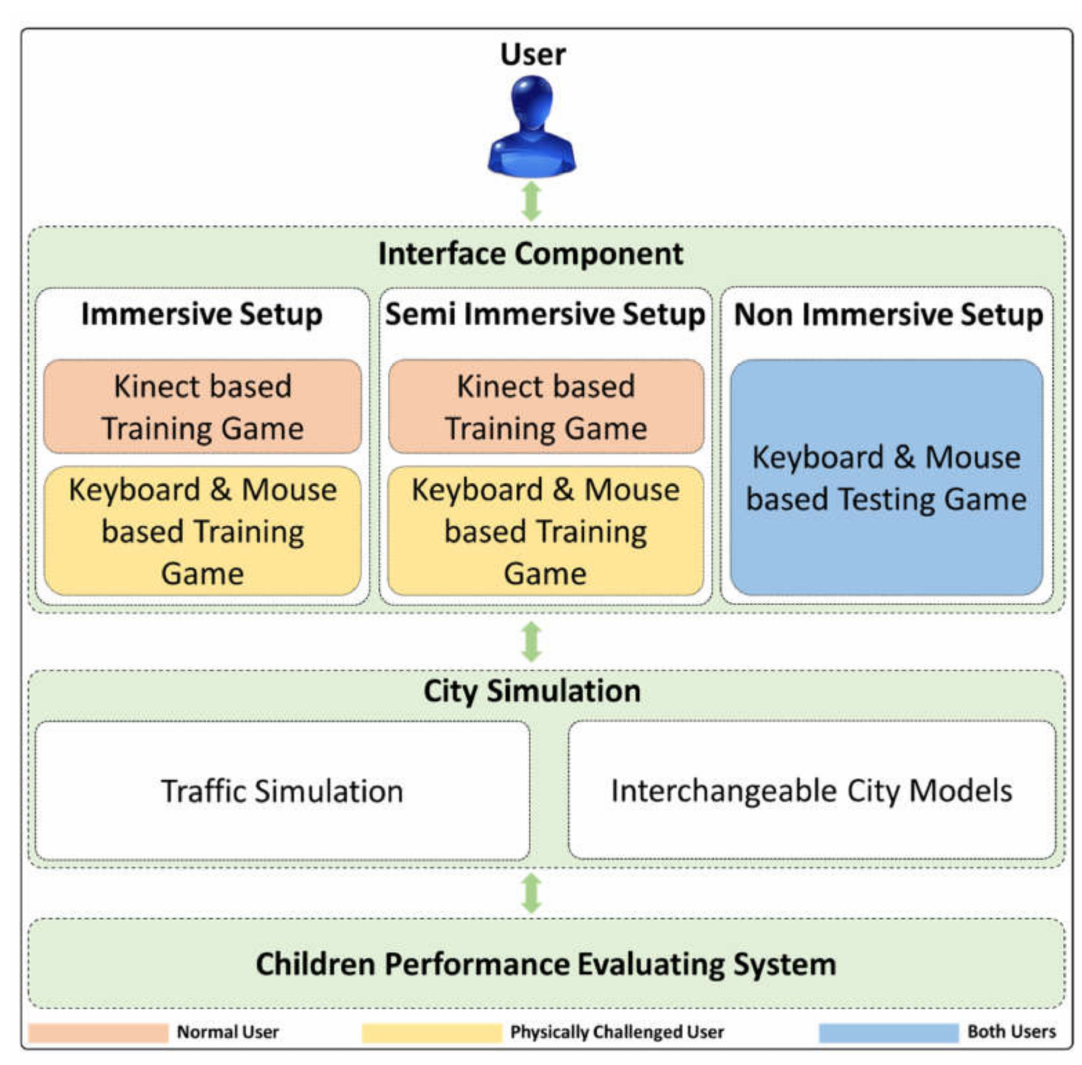
Figure 1. Our proposed system architecture consists of three major components. The interface component connects the user to the city simulation and supports different hardware setups, varying in degree of immersion, availability, and cost. The city simulation including traffic and urban neighborhood is the core of the architecture and generates the virtual training environment. Additionally, the city simulation is also connected to the CPES. Furthermore, physically challenged students can control walking, jump, and running gestures with the help of a